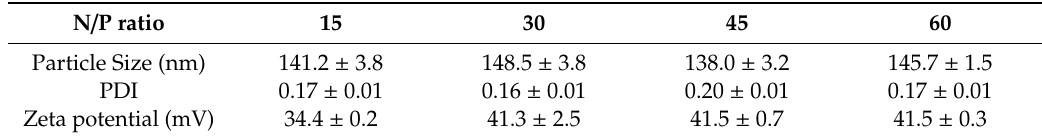
Table 1. Mean particle size (PS), zeta potential (ZP), and polydispersity index (PDI) of PgP / pDNA polyplexes at various N / P ratios.